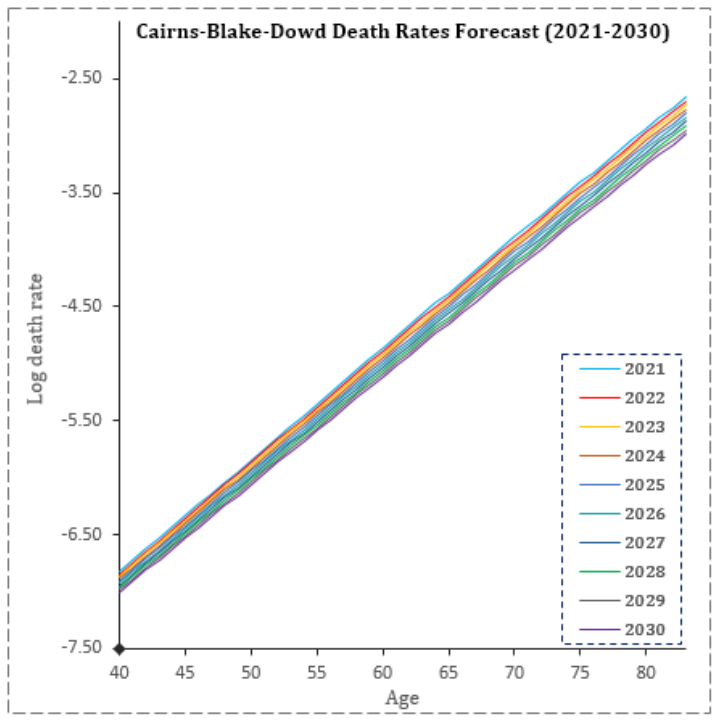
Figure A3. Cairns–Blake–Dowd Rate Forecast for Period